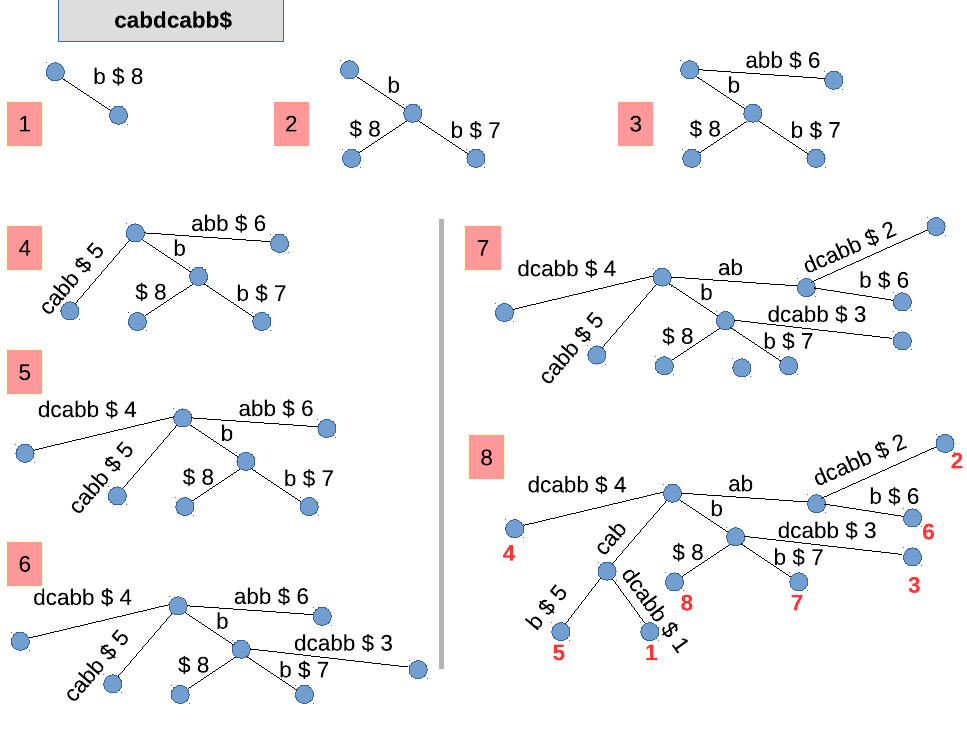
Figure 2. Example of a suffix